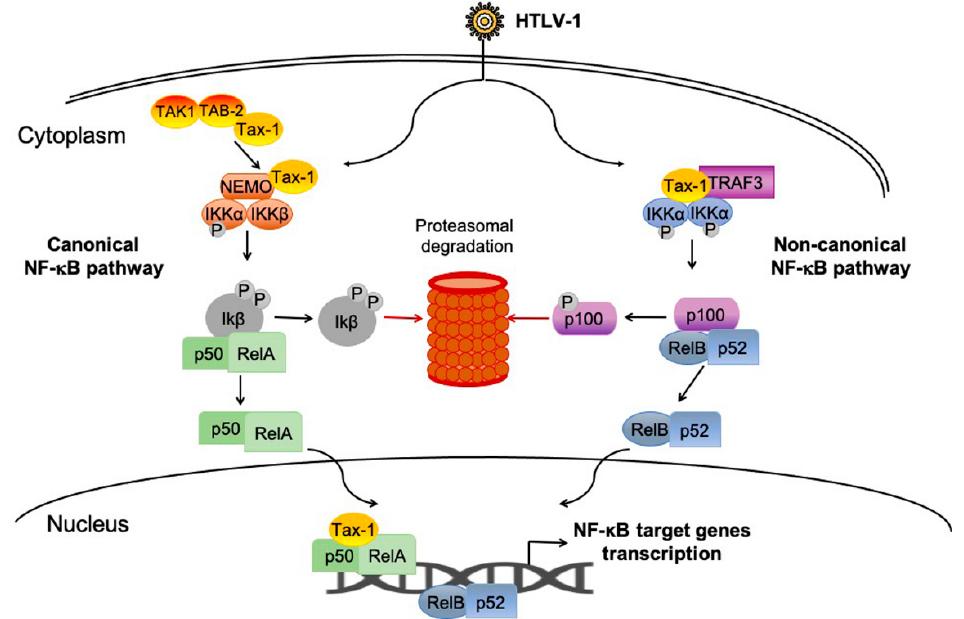
Figure 3. HTLV-1 Tax-mediated NF- κ B activation.